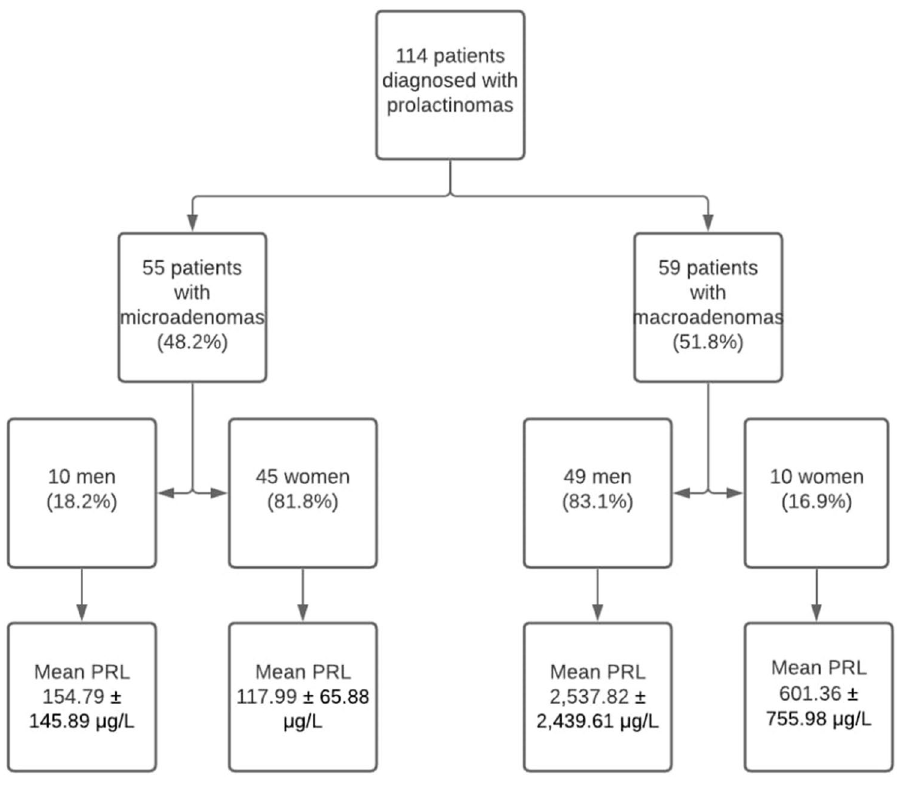
Figure 1. Study flow chart.